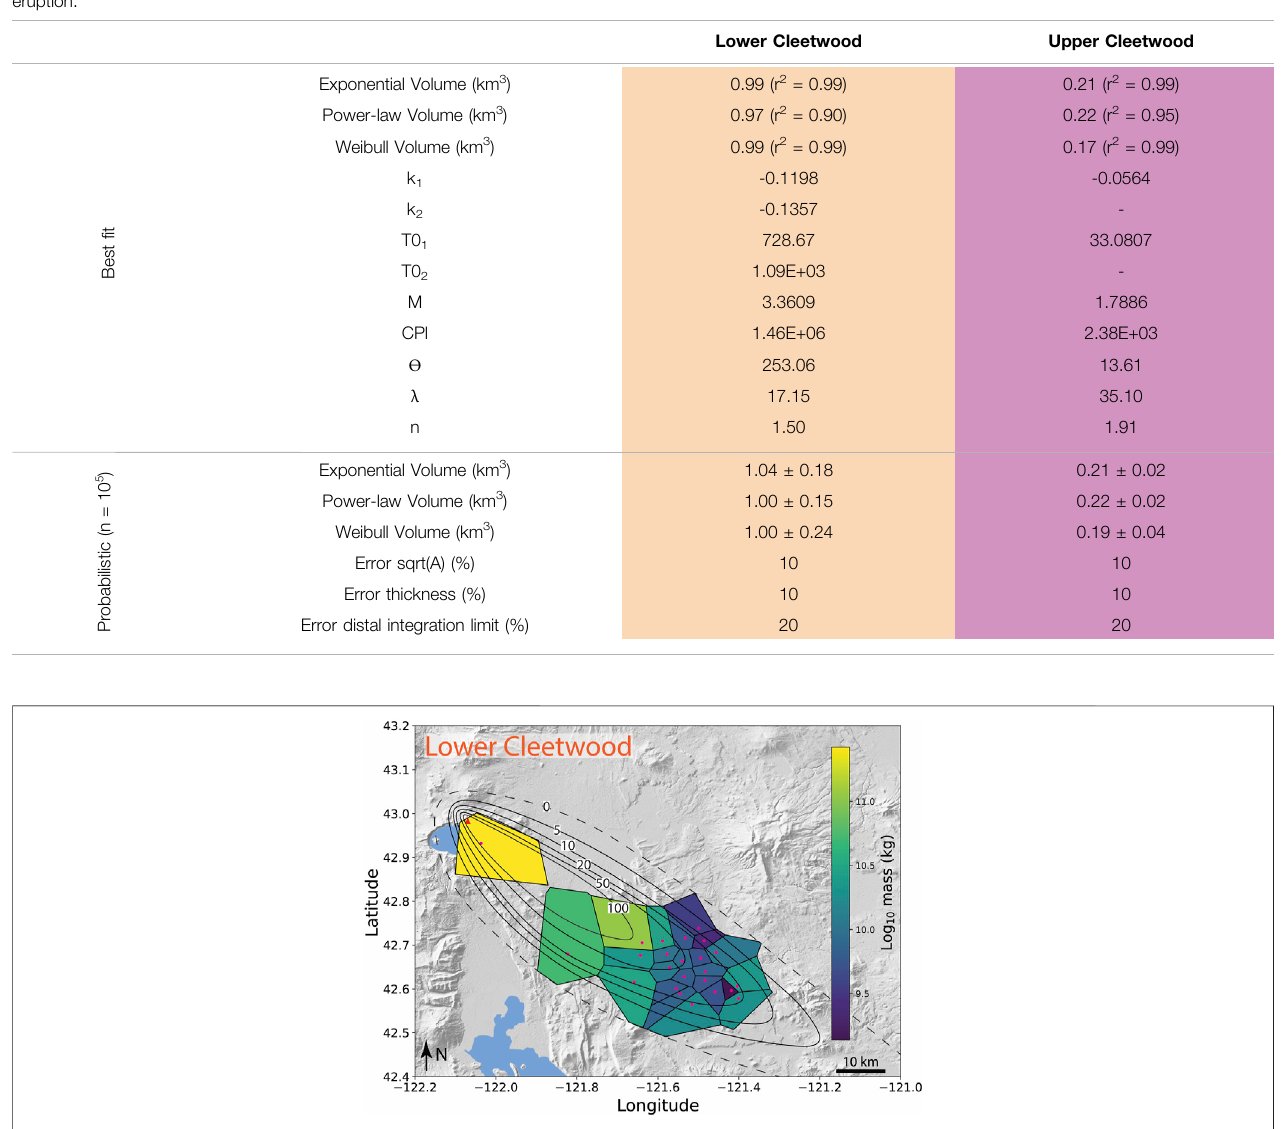
TABLE 2 | Best fi t and probabilistic fi tting parameters and erupted volumes obtained using TephraFits (Biass et al., 2019) for the three different phases of the Cleetwood eruption.